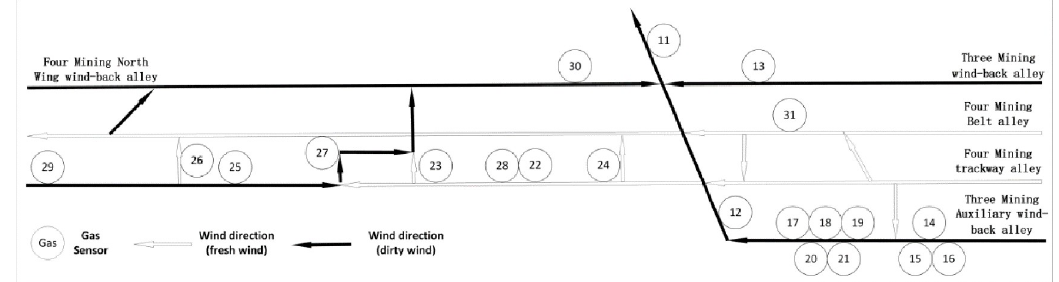
Fig 3. 21 gas sensors installed in Case Study mine 2.